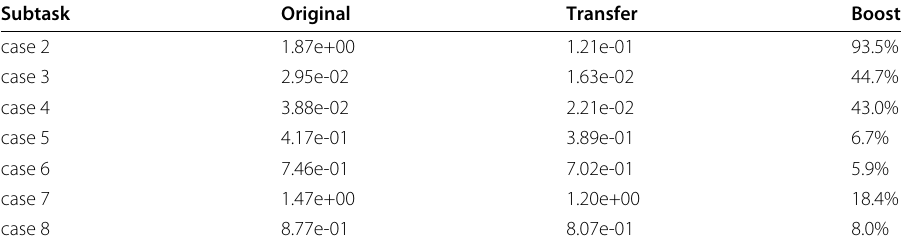
Table 8 Performance boost of PINN-anneal on the Helmholtz benchmarks using transfer learning Subtask